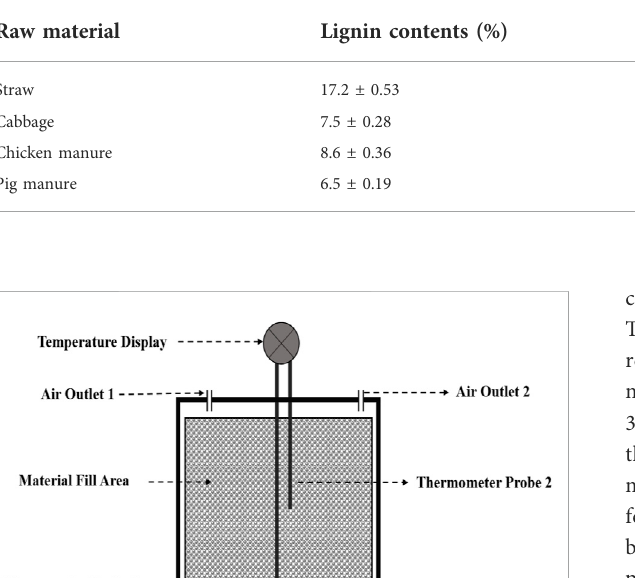
TABLE 1 Basic physical and chemical properties of the composting materials ( n = 3).